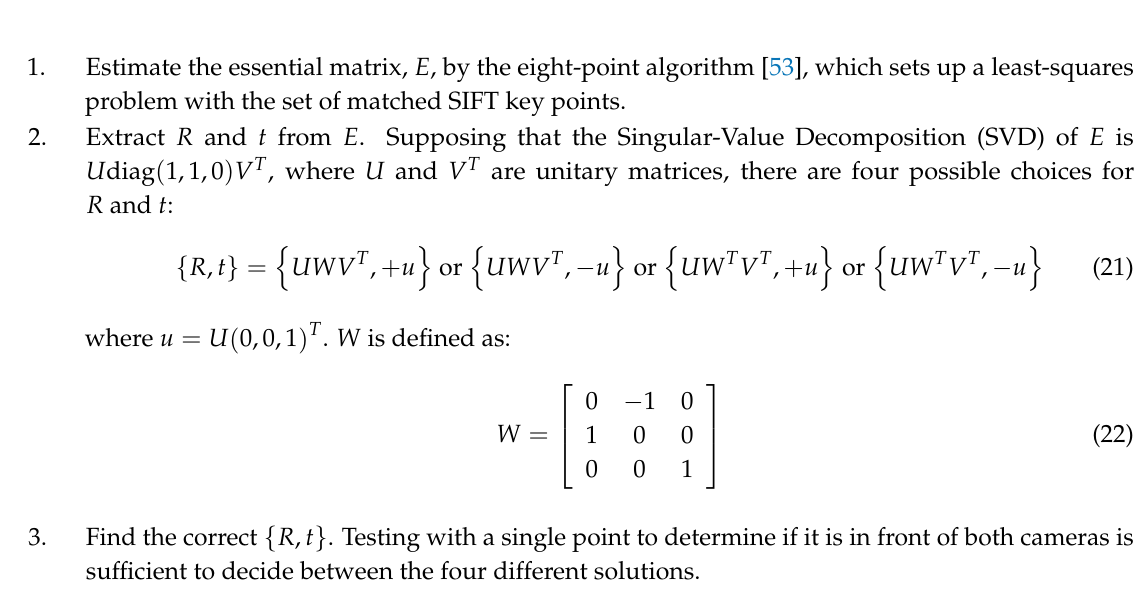
( b ) Figure 8. Projection models of the camera. (cid:1846) is the optical center of the camera. (cid:1830) represents a key point on scene plane (cid:1827)(cid:1828) and (cid:1832) is the projected point on the CCD (image) plane. (cid:1858) is the focal length. ( a ) Camera moves forward, |(cid:1841)(cid:1841) (cid:4593) | is the moving distance; ( b ) camera rotates, (cid:2009) is the rotation angle. In Figure 8a, (cid:1846) is the optical center of the camera. (cid:1830) represents a key point on scene plane (cid:1827)(cid:1828) and (cid:1832) is the projected point on the CCD (image) plane. When the camera moves forward, toward plane (cid:1827)(cid:1828) , it is equivalent to moving plane (cid:1827)(cid:1828) to plane (cid:1827) (cid:4593) (cid:1828) (cid:4593) . The original point (cid:1830) is denoted as (cid:1830) (cid:4593) on plane (cid:1827) (cid:4593) (cid:1828) (cid:4593) and its projection point is denoted as (cid:1832) (cid:4593) . (cid:1830) (cid:4593)(cid:4593) is on the extended line of (cid:1846)(cid:1830) (cid:4593) . |(cid:1846)(cid:1834)| represents the focal length, (cid:1858) , of the camera, so |(cid:1846)(cid:1834)| is perpendicular to |(cid:1832)(cid:1834)| . According to the similarity between ∆(cid:1830) (cid:4593)(cid:4593) (cid:1841)(cid:1846) and ∆(cid:1830) (cid:4593) (cid:1841) (cid:4593) (cid:1846) , the moving distance |(cid:1841)(cid:1841) (cid:4593) | is presented as follows: